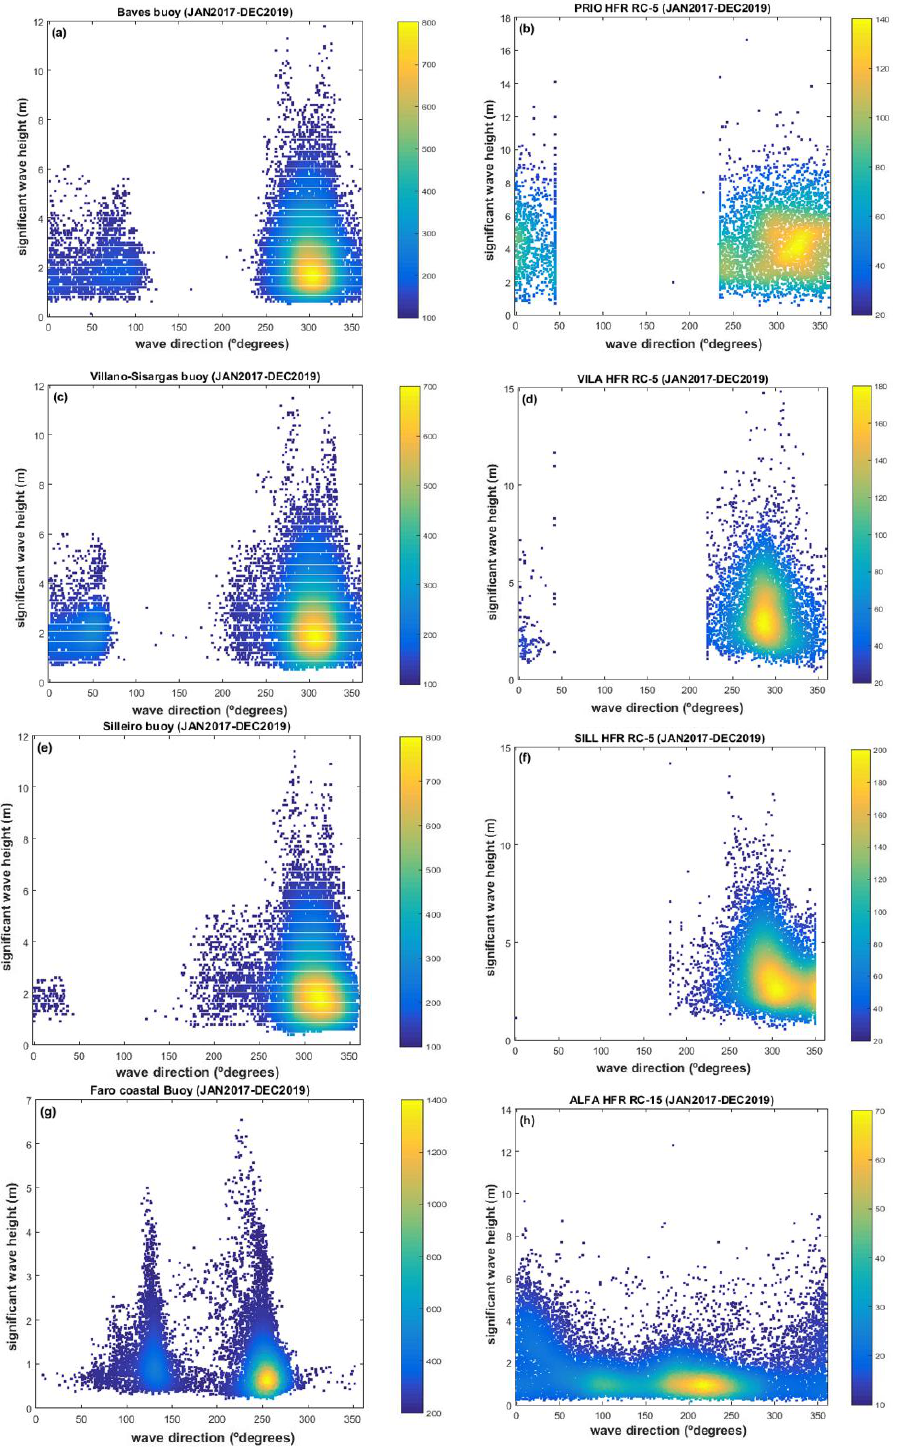
Figure 10. Density scatter plots of SWH (m) vs. wave direction (JAN2017-DEC2019). ( a ) Baves Buoy; ( b ) PRIO HFR; ( c ) Villano-Sisargas buoy; ( d ) VILA HFR; ( e ) Silleiro Buoy; ( f ) SILL HFR; ( g ) Faro coastal buoy and ( h ) ALFA HFR. ( a , c , e , g ) in situ sensors and ( b , d , f , h ) HFR wave data. Central colored bar legend represents the density of both scatter